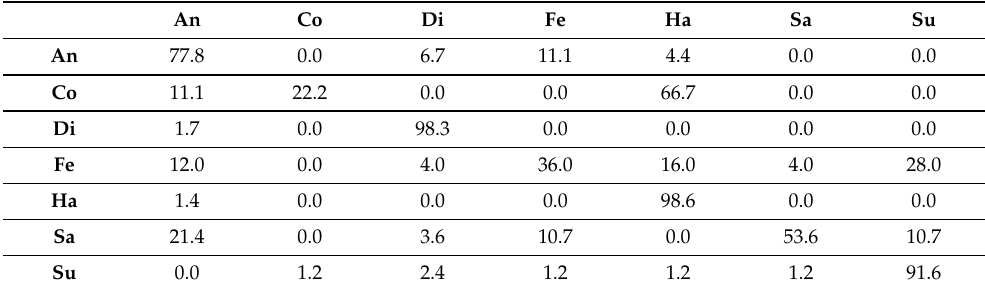
Table 2. Confusion matrix: Basic CNN-based facial expression recognition from facial motion flow for CK+.